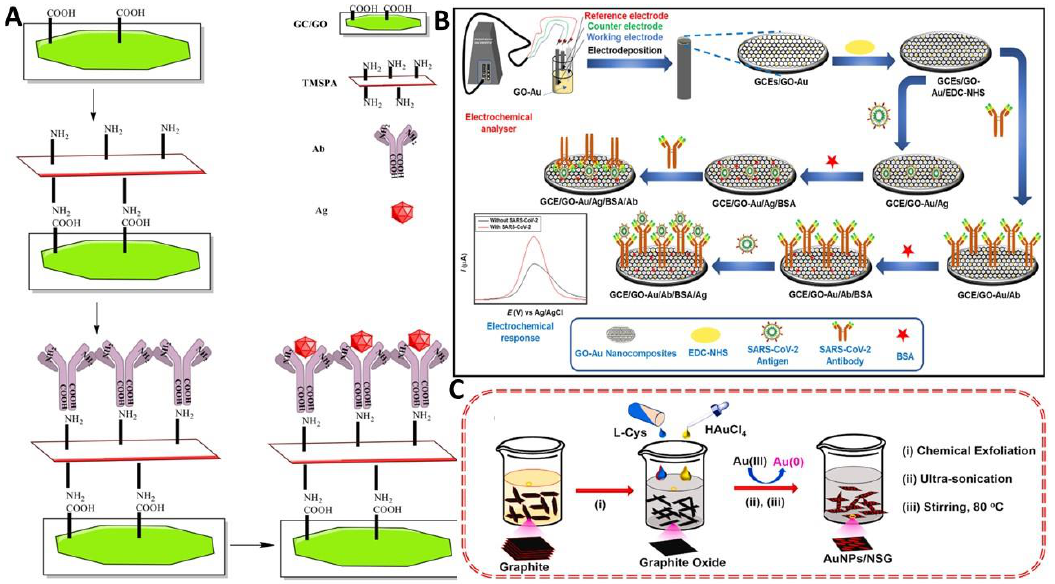
Figure 6. ( A ) The schematic of the Ag/Ab/TMSPA/GO/GCE fabrication process in steps. Reprinted with permission from [181]. ( B ) A flowchart showing the steps needed to make SARS-CoV-2 antigen and antibody immunosensors. Reprinted with permission from [185]. ( C ) Depiction of EC immunosensing platform made from in situ functionalizations of AuNPs/RSG. Reprinted with permission from [189].